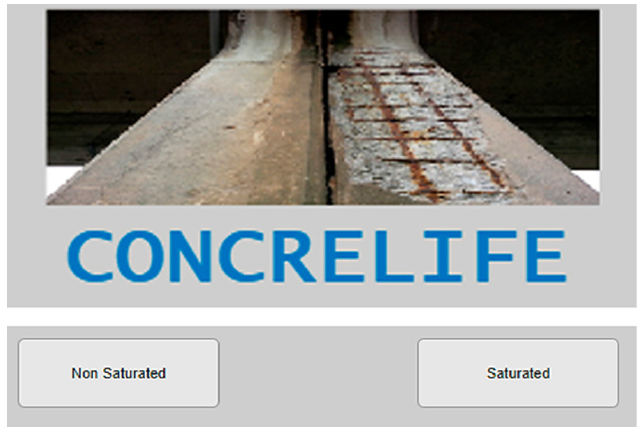
Figure 5. Screen to select the type of problem.